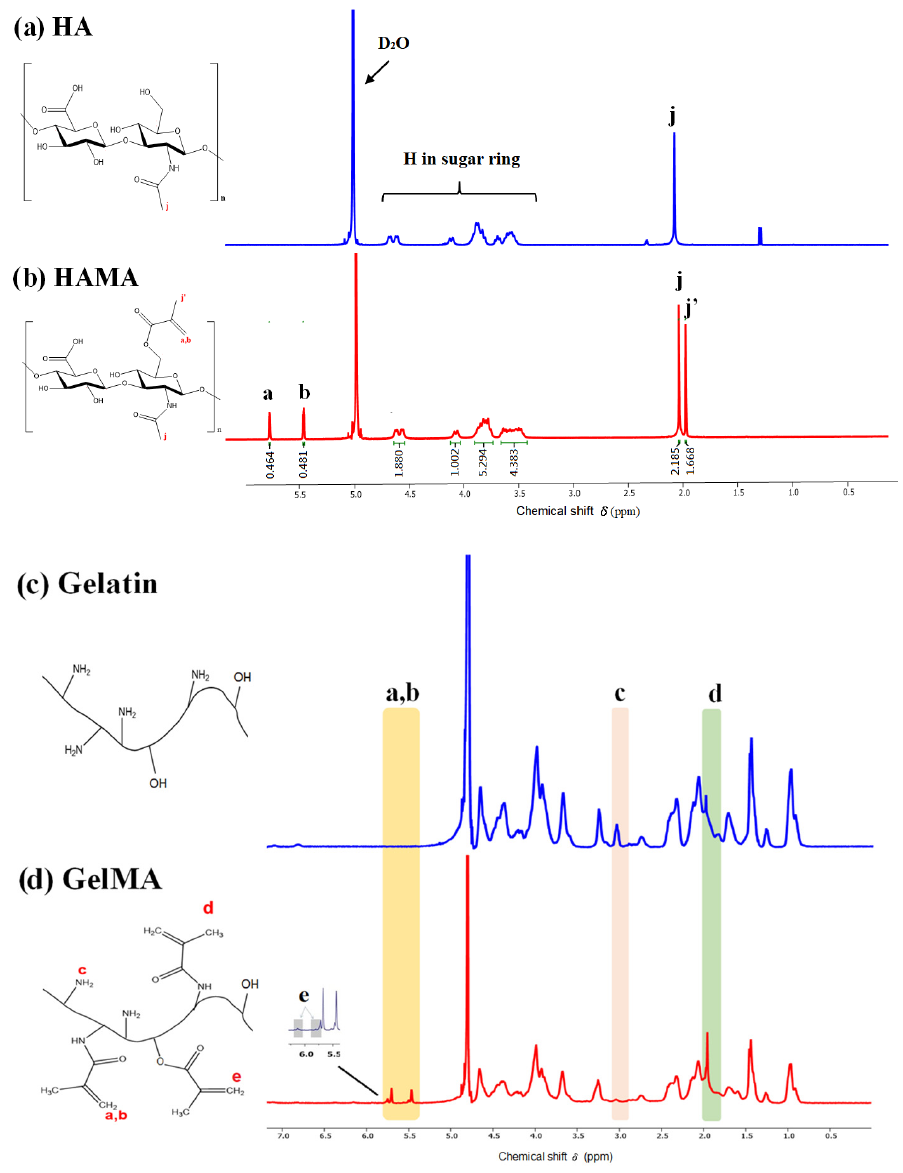
Figure 3. 1 H-NMR spectra of HA ( a ), HAMA ( b ), gelatin ( c ), and GelMA ( d ).